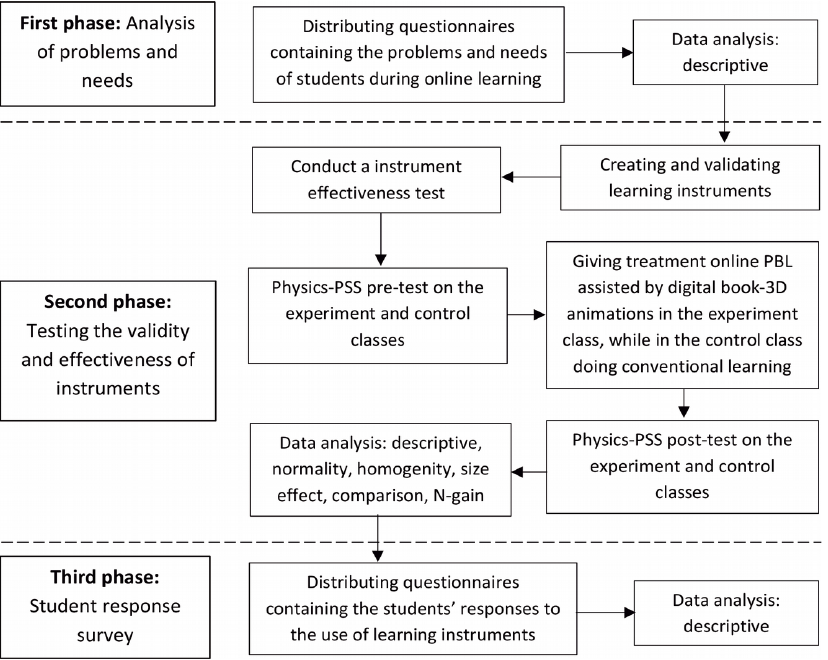
Figure 1. Stages of research